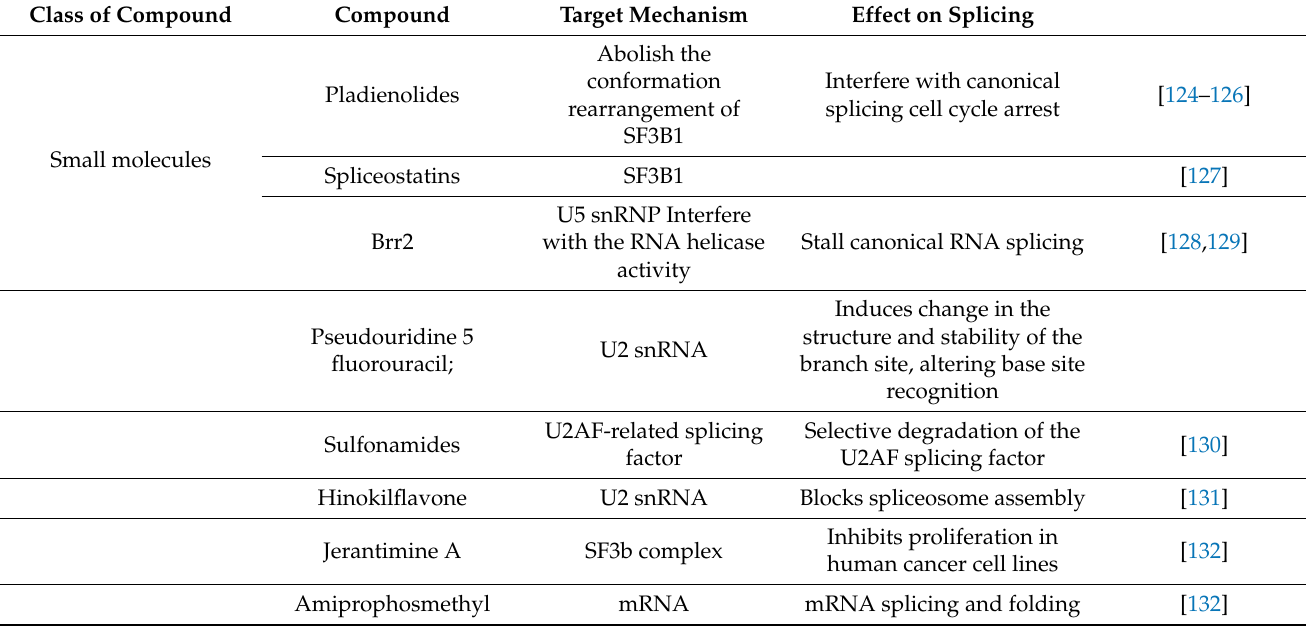
Table 1. Different classes of drugs that target alternate splicing in